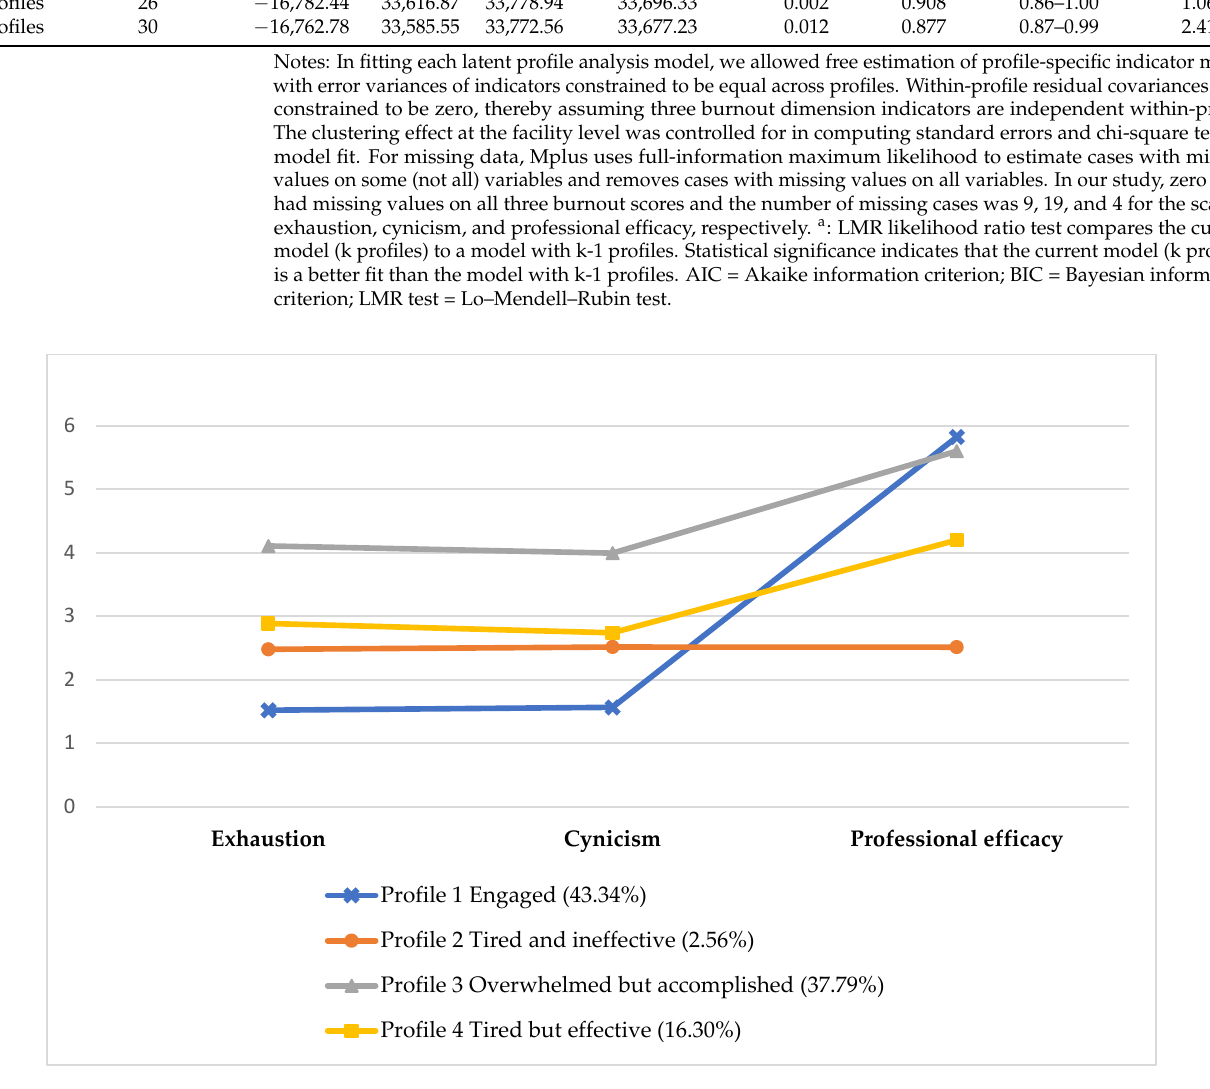
Figure 1. Estimated means of burnout scores by latent pro fi le based on the 4-pro fi le